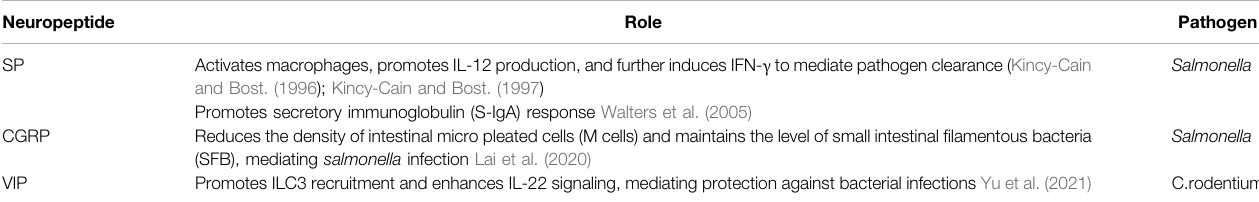
TABLE 5 | The role of neuropeptides in intestinal host